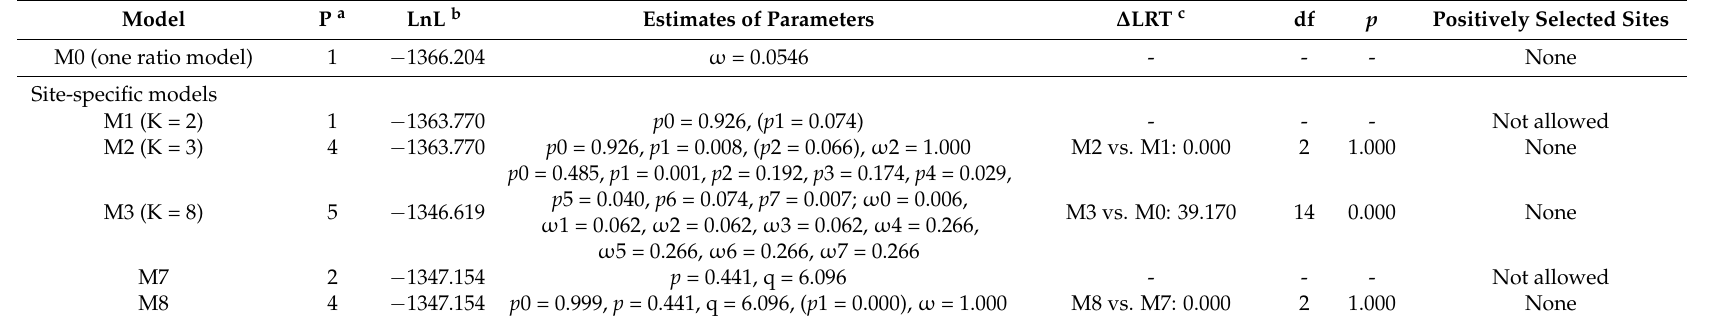
Table 2. Parameter estimates and likelihood ratio tests for the site